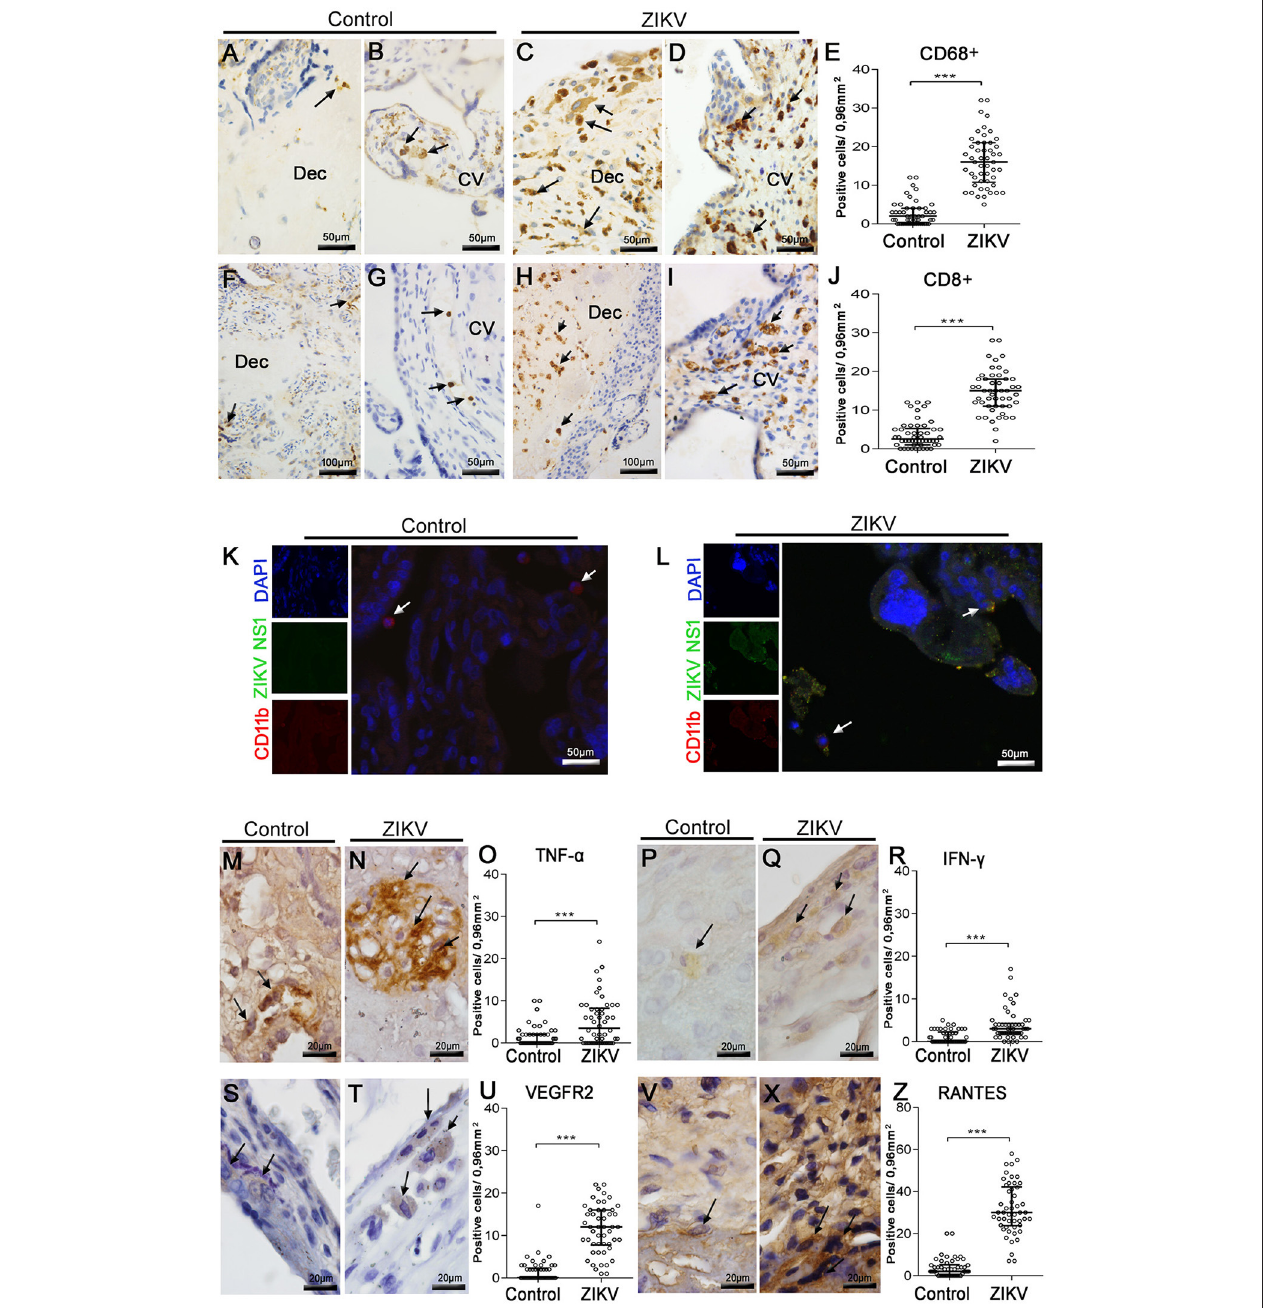
FIGURE 2 | Characterization of mononuclear cell subpopulations in ZIKV-infected placental tissue, colocalization with virus and cytokine-producing cell profile. (A,B) Detection of CD68 + cells (Hofbauer cells) by immunohistochemistry in decidua and chorionic villi of control placenta, respectively. (C,D) Hofbauer cells in decidua and chorionic villi of ZIKV infected placental tissue, respectively. (F,G) Detection of CD8 + cells by immunohistochemistry in decidua and chorionic villi of control placenta, respectively. (H,I) CD8 + cells immunostained in decidua and chorionic villi of ZIKV-infected placental tissue, respectively. (E,J) Quantification of CD68 + and CD8 + cells in ZIKV case and control, respectively. (K,L) Colocalization by immunofluorescence of the NS1 protein (fluorescent green) and CD11b for identification of leukocytes (fluorescent red). Nuclei were stained using DAPI (fluorescent blue). (K) ZIKV NS1 antigen was not detected in the control placenta. (L) Cells presenting dual staining (green and red) were observed in the ZIKV-infected placenta. (M,N) . Detection of TNF- α in cells of chorionic villi of control and ZIKV infected placenta by immunohistochemistry, respectively. (P,Q) Production of IFN- γ in cells of membrane of control and ZIKV infected placenta, respectively. (S,T) VEGFR2-expressing cells of decidua in control and ZIKV infected placenta, respectively. (V,X) Detection of CCL5/RANTES in cells of chorionic villi of control and ZIKV infected placenta, respectively. (O,R,U,Z) Quantification of the number of cells expressing TNF- α , IFN- γ , VEGFR2, and CCL5/RANTES, in ZIKV case and control, respectively. Asterisks indicate differences that are statistically significant between groups (*** p < 0.001).